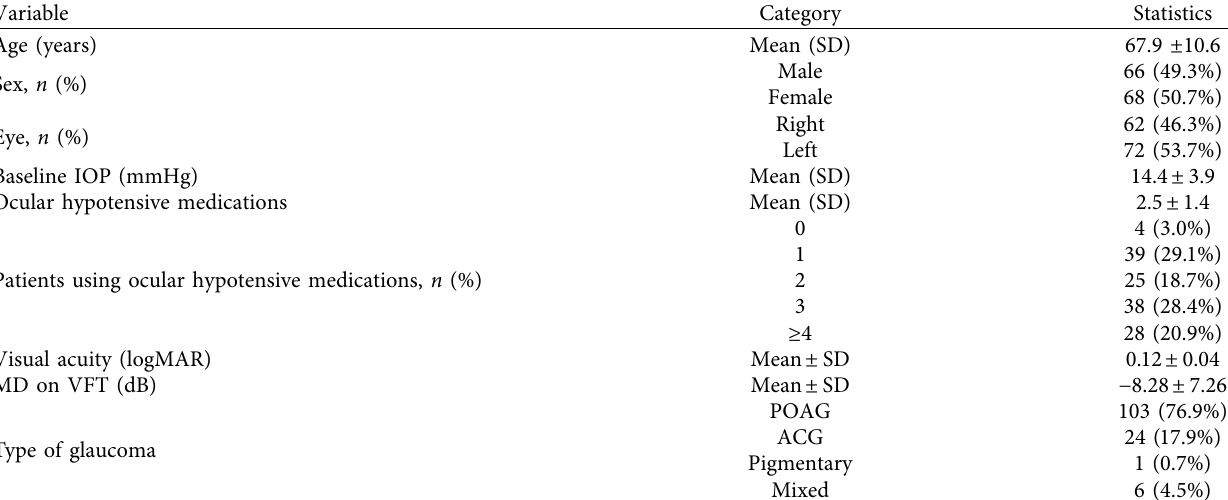
Table 1: Baseline characteristics of patients who underwent clear lensectomy in combination with Hydrus microstent